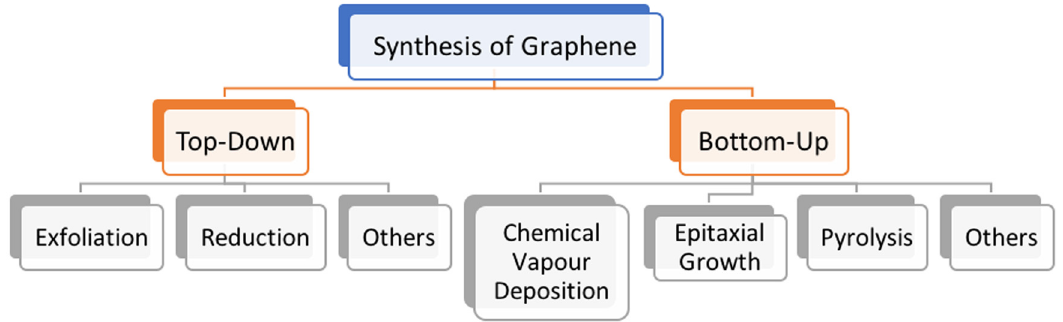
Figure 5: Methods followed for the synthesis of